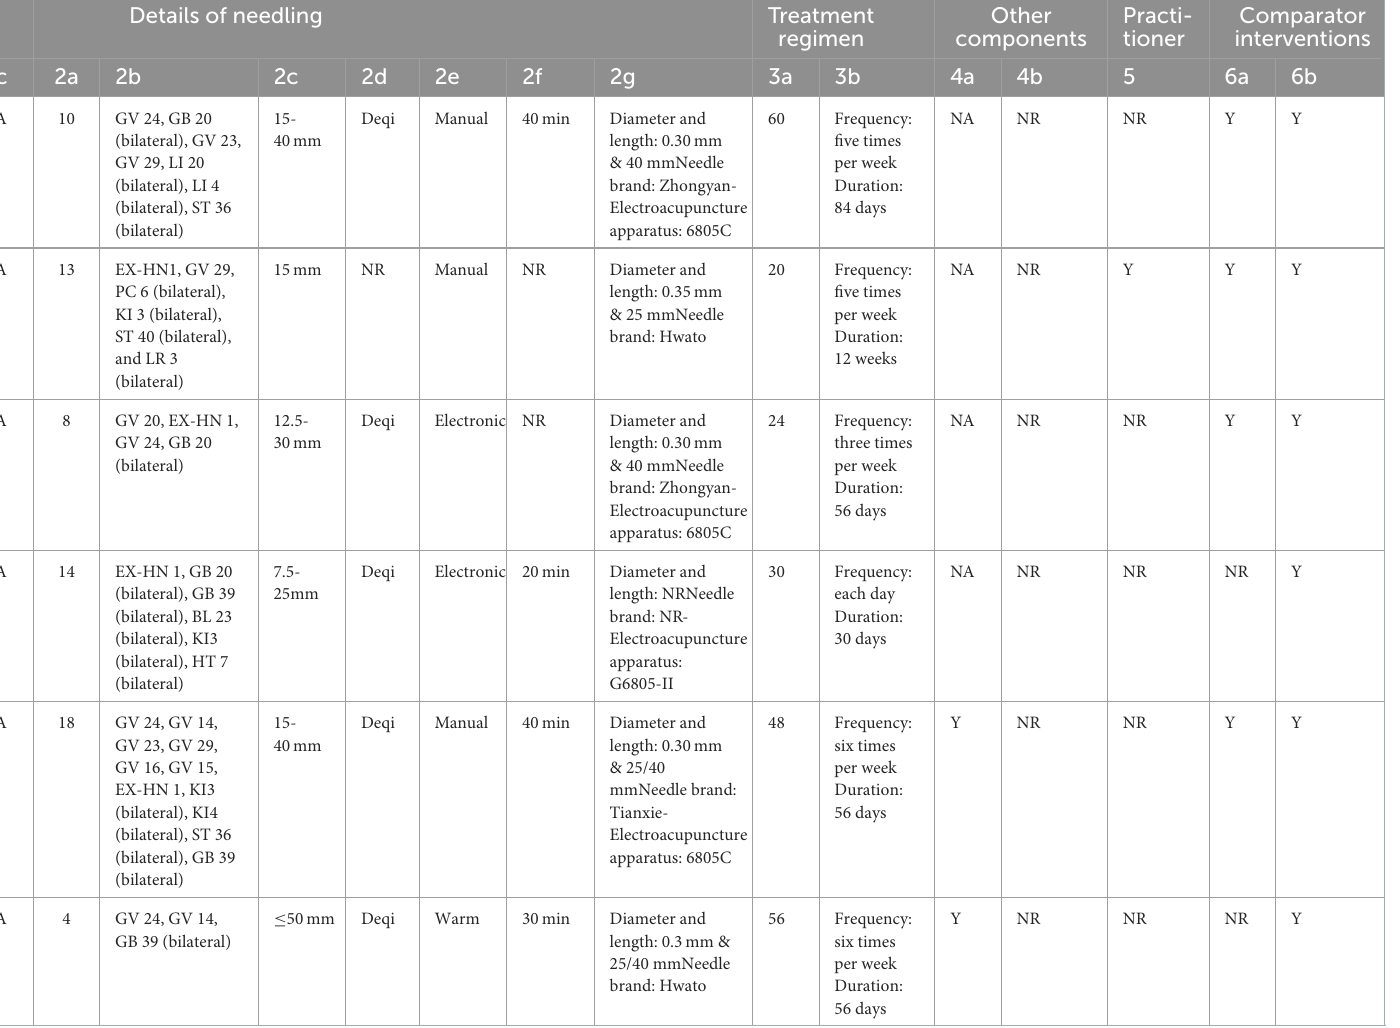
TABLE 2 Details of acupuncture methods according to Standards for Reporting Interventions in Clinical Trials of Acupuncture (STRICTA). Study Acupuncture